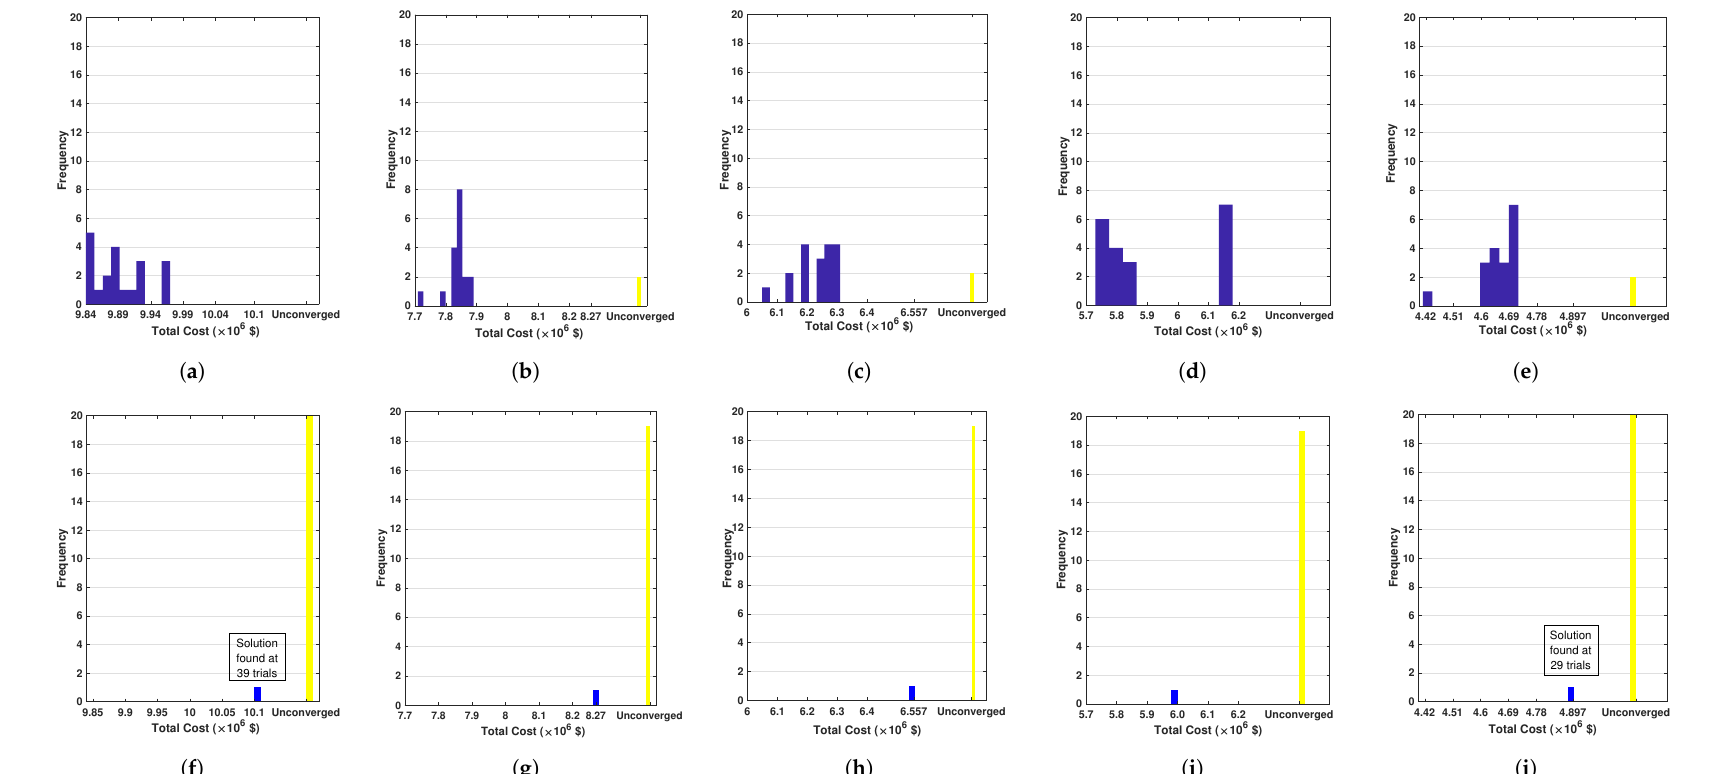
Figure 8. Histogram of the total cost after applying the proposed two-stage formulation and the NLP formulation to the real-life WDS with different reservoir elevations (20 runs for each of the reservoir configurations). ( a ) Two-stage method applied to case study 2 with reservoir configuration (200-200); ( b ) Two-stage method applied to case study 2 with reservoir configuration (270-240); ( c ) Two-stage method applied to case study 2 with reservoir configuration (320-280); ( d ) Two-stage method applied to case study 2 with reservoir configuration (320-320); ( e ) Two-stage method applied to case study 2 with reservoir configuration (370-320); ( f ) NLP method applied to case study 2 with reservoir configuration (200-200); ( g ) NLP method applied to case study 2 with reservoir configuration (270-240); ( h ) NLP method applied to case study 2 with reservoir configuration (320-280); ( i ) NLP method applied to case study 2 with reservoir configuration (320-320); ( j ) NLP method applied to case study 2 with reservoir configuration